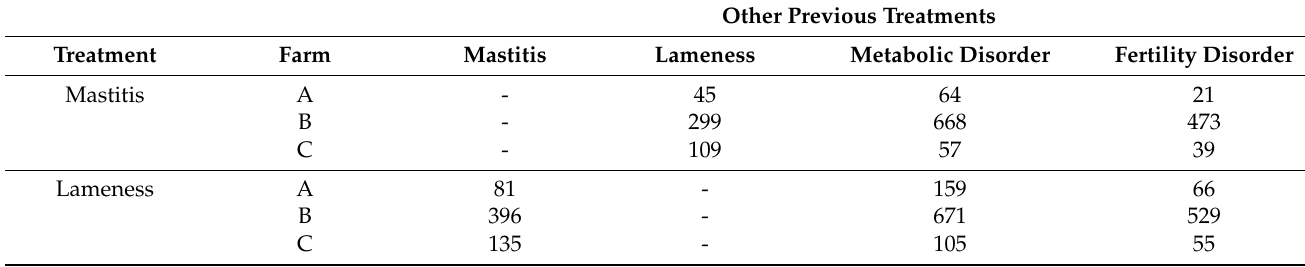
Table A4. The number of other treatments occurring before the classified treatment for cows in RGtreat-OC/SL. Cows in the group could have multiple previous